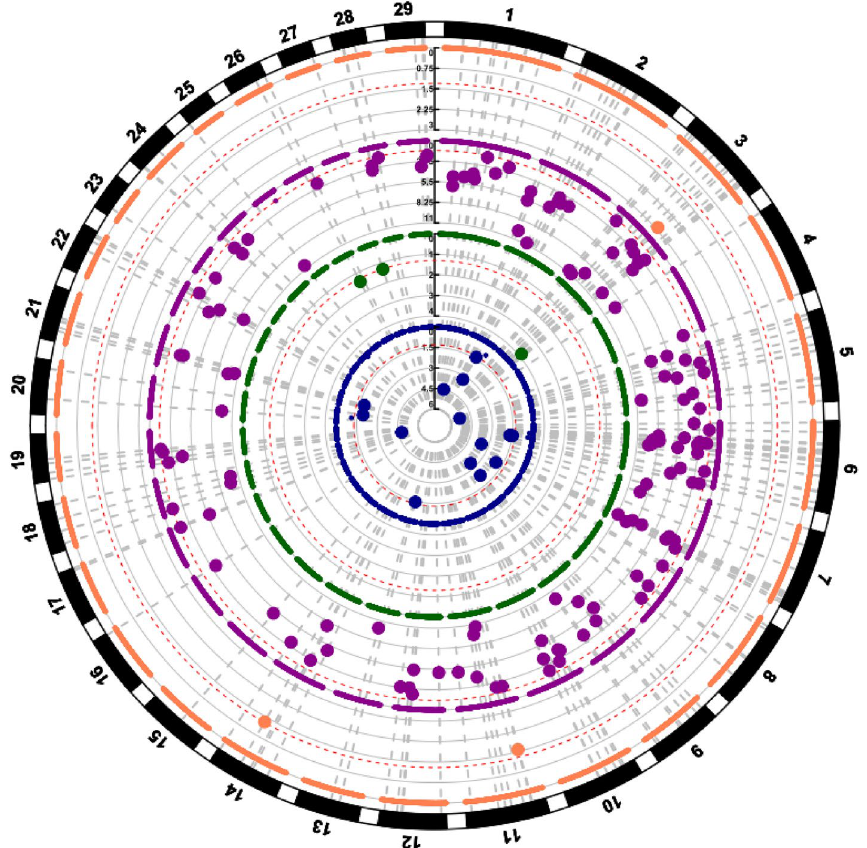
Figure 2. Circular Manhattan plot of outliers SNP detected with PCadapt analysis. One different colour is assigned to each breed: coral for Saanen, purple for Nubian, green for Boer and blue for Angora. The red dashed line indicates the threshold of significance of 0.05%. Every point is a SNP and with amplified the significant